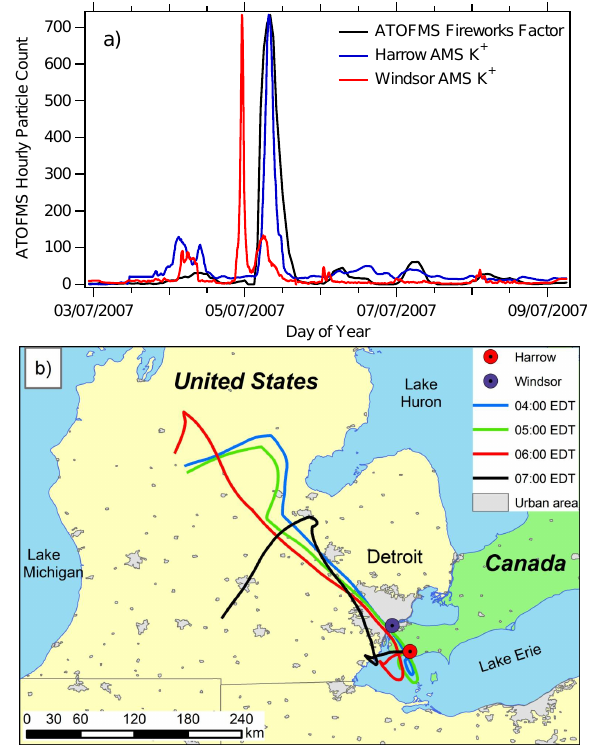
Fig. 7. Impact of the ATOFMS Fireworks factor and AMS K + in both Harrow and Windsor (a) , (AMS K + in arbitrary units). Shown in (b) are high-resolution Harrow backtrajectories during the 5 July Fireworks factor